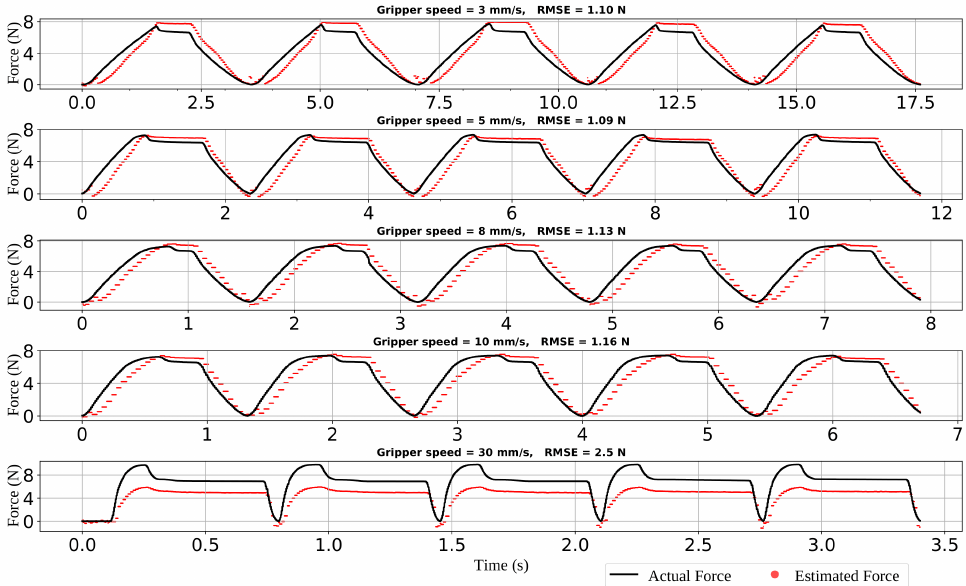
Figure 7. The bandwidth of the sensor: ground-truth force and estimated force at various frequen- cies. PhotoElasticFinger response was recorded at five different gripper velocities. At 30 mm/s, PhotoElasticFinger is failing to estimate the force.